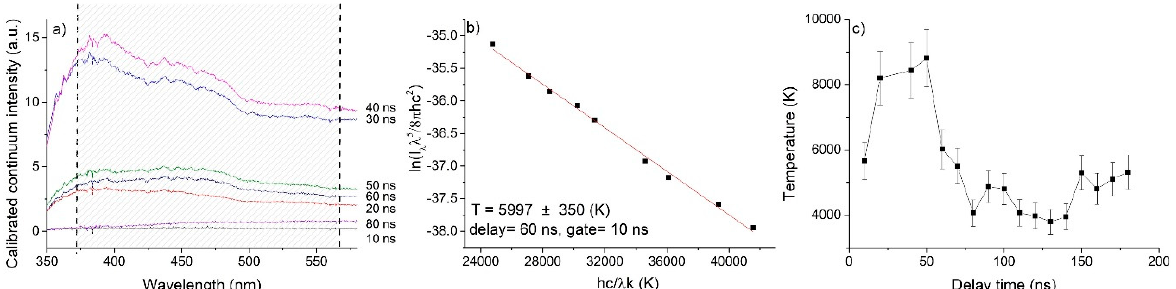
Figure 3. A typical example of ( a ) temporal evolution of the continuum radiation spectra of LIP induced on target underwater at various delay times. In Figure 3a, the dotted lines represent the interval where the spectra hold the Planck distribution; ( b ) an example of the corresponding Plank plot analysis during PLAL. Note that the fitting red line corresponds to the linearized Planck spectrum according to Equation (2) at the given T; ( c ) corresponding temporal temperature evolution. The PLAL was performed on Ag target immersed in a flowing water layer with thickness of 2.5 mm (laser pulse width = 6 ns, laser energy = 90 mJ, laser wavelength = 1064 nm, laser frequency = 10 Hz, crater size = 1 ± 0.2 mm, ICCD gate width = 10 ns, delay times ranging between 10 ns and 80 ns, as reported for each spectrum in ( a )). The experimental set-up is described in detail in Ref. [16].